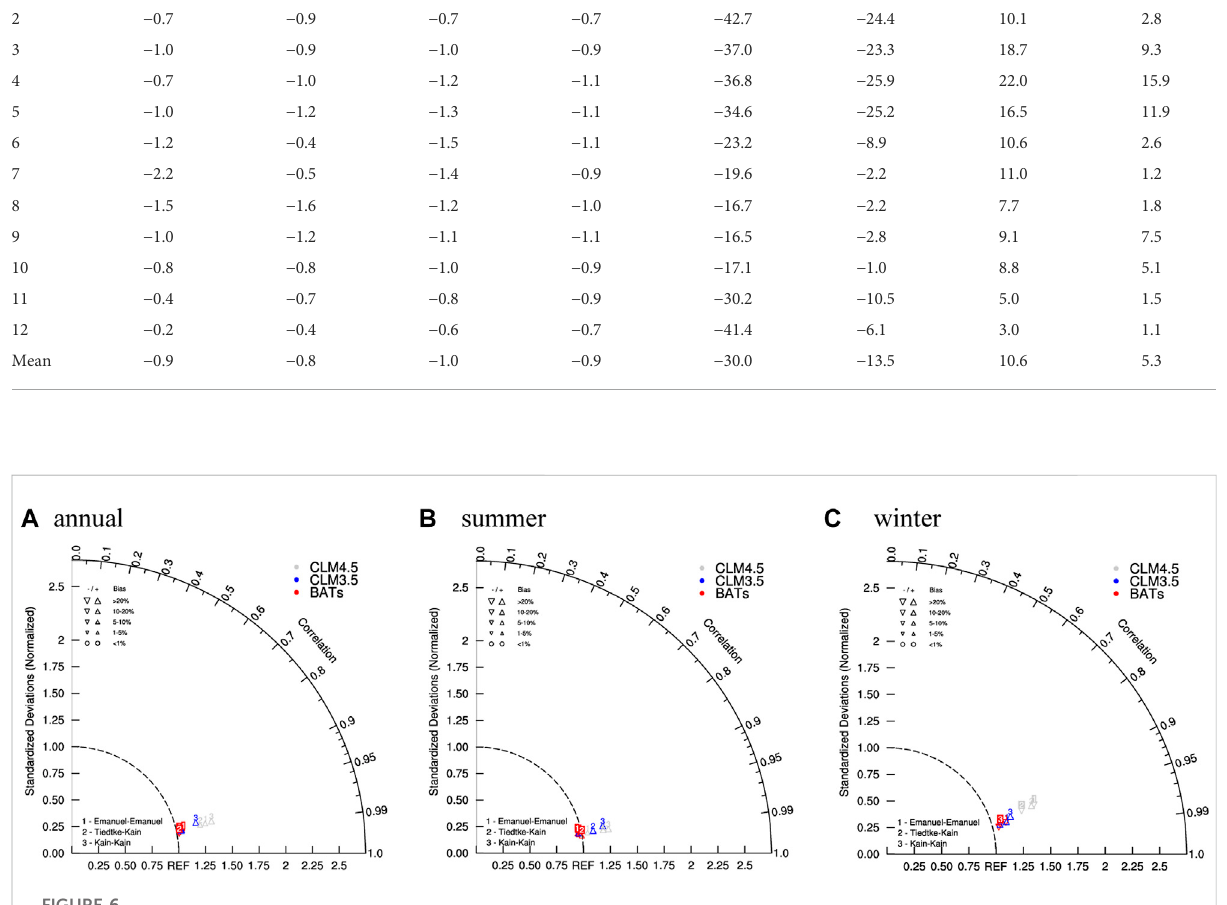
FIGURE 6 Taylor diagrams of annual, summer, and winter air temperatures in the UYRB.